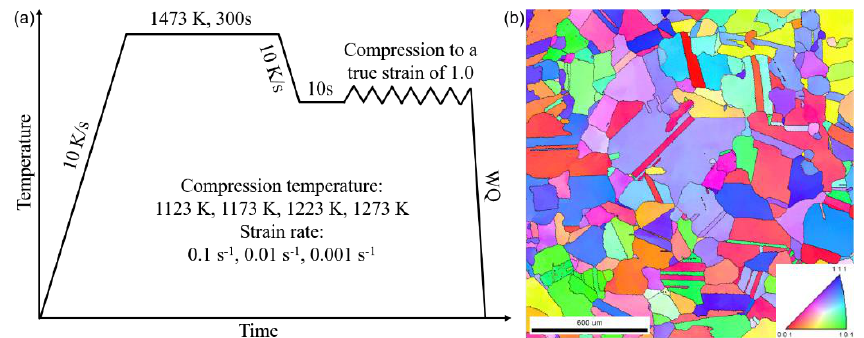
Figure 1. ( a ) Schematic diagram showing the experimental procedure and conditions for the hot compression of the Co 35 Cr 25 Mn 15 Ni 15 Fe 10 transformation induced plasticity (TRIP) high-entropy alloy (HEA). ( b ) EBSD inverse pole figure (IPF) map shows the initial grain structure before hot compression of the TRIP-HEA.